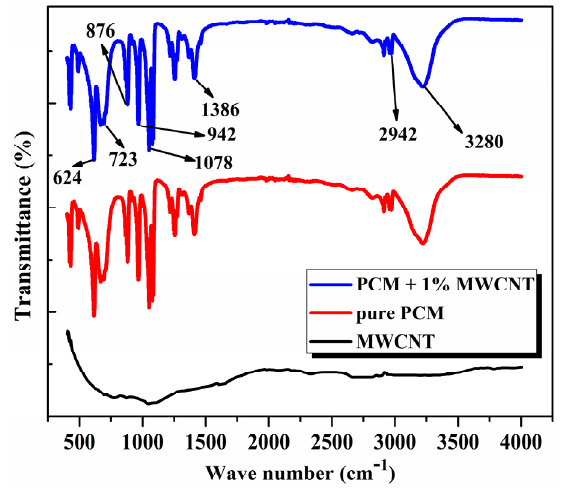
Figure 2. FTIR spectrum of pure PCM and nano-PCM samples.